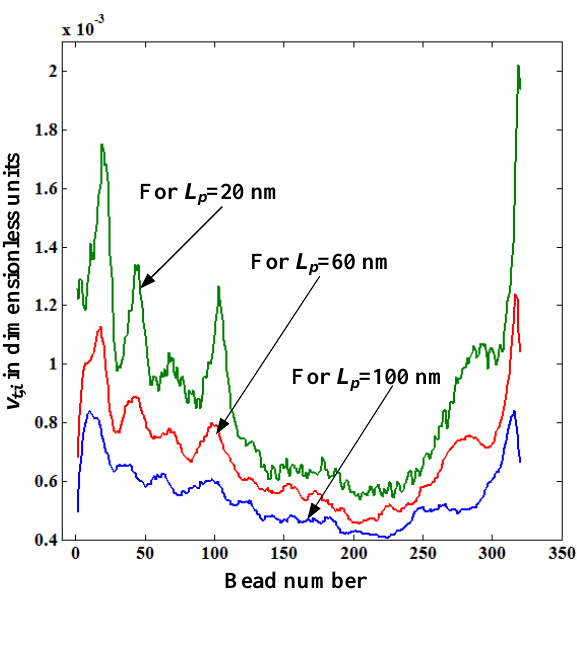
Figure 7. Variation of the translocation velocity of each bead v pore lengths L = 20, 60, and 100 p